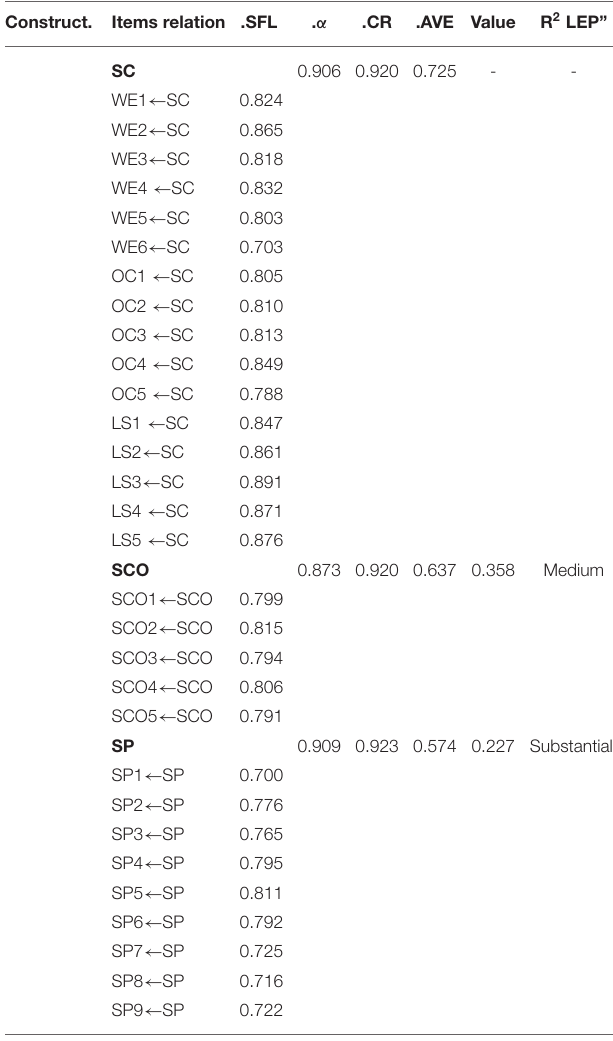
TABLE 4 | Validity, reliability and R 2 values. Construct. Items relation